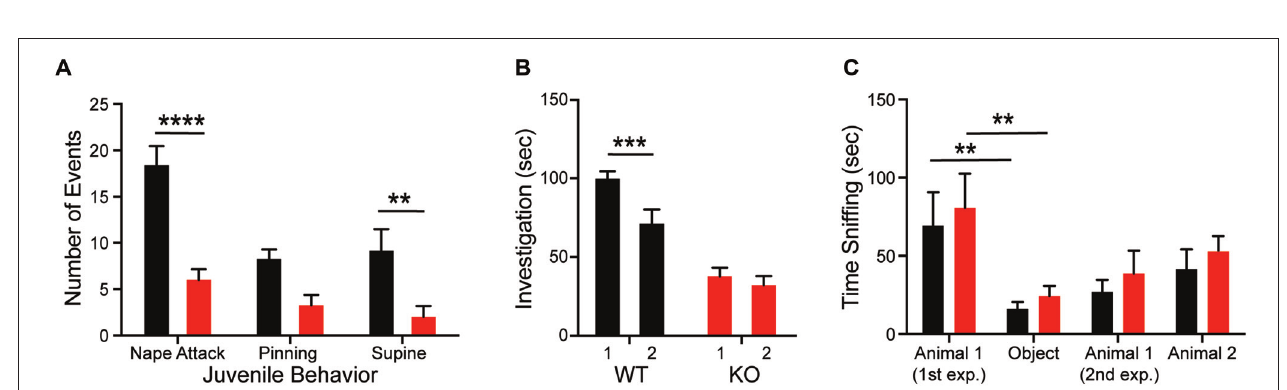
FIGURE 2 | Shank2 mutation results in impaired social behavior. Shank2 KOs engage in less social interaction as juveniles (A) and as adults (B) . The decreased social interaction impairs social recognition (B) but not social preference (C) . In all panels WT animals are in black and KO animals are in red. Bars indicate SEM. ∗∗ p < 0.01, ∗∗∗ p < 0.001, ∗∗∗∗ p < 0.0001.